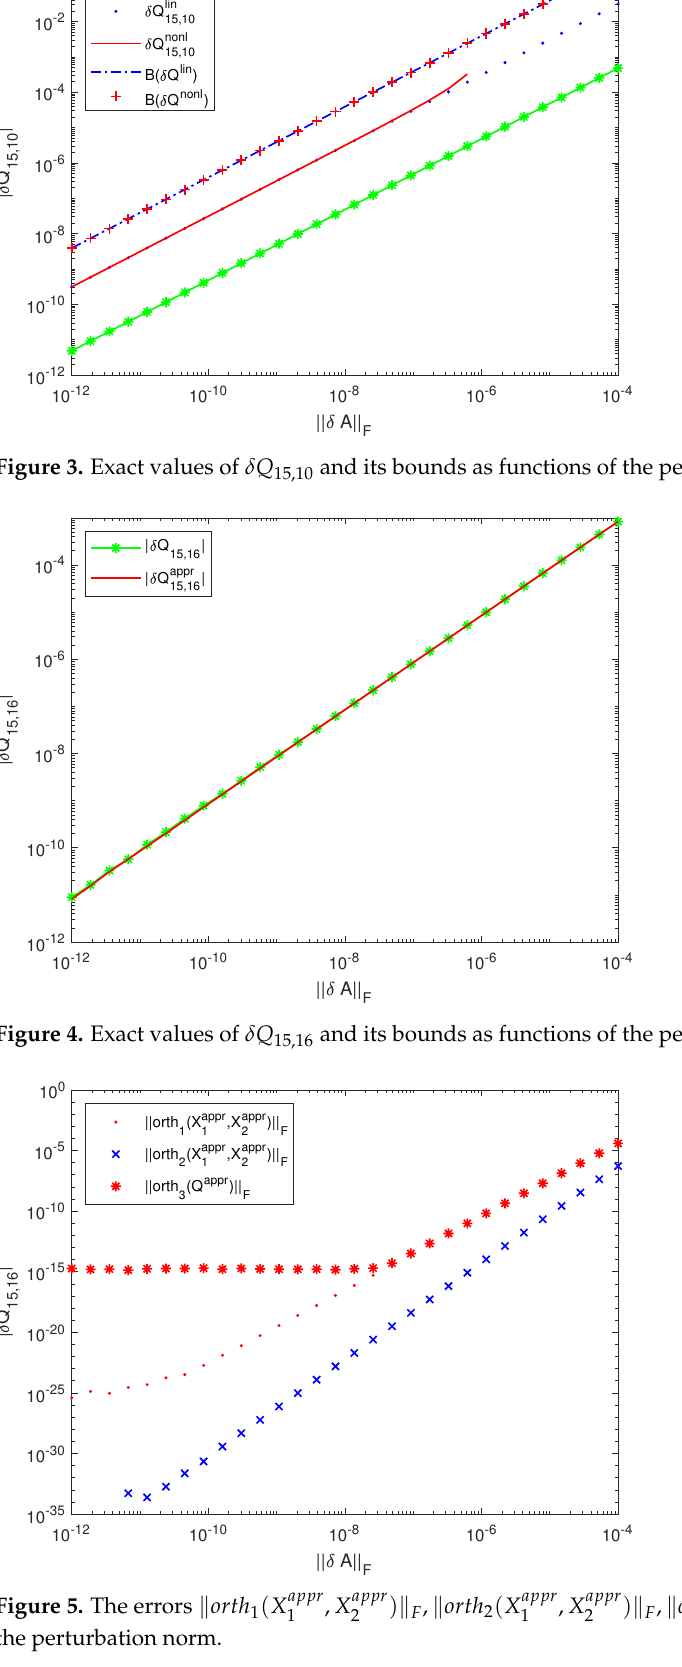
F as functions of